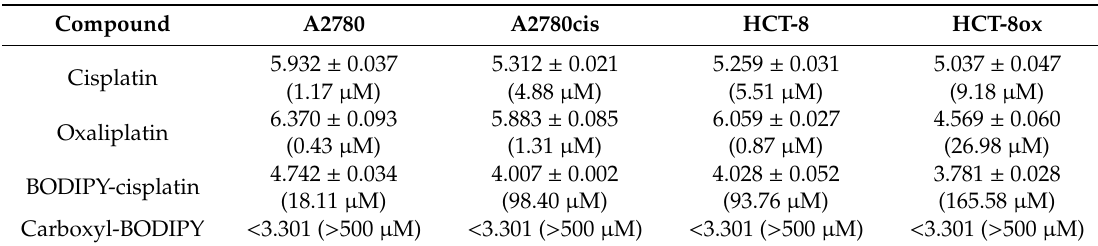
Table 1. Cytotoxicity (pEC 50 , mean ± SEM, n = 5–8) of cisplatin, oxaliplatin, BODIPY-cisplatin, and carboxyl-BODIPY in A2780, A2780cis, HCT-8, and HCT-8ox cells (the respective EC 50 values are given in